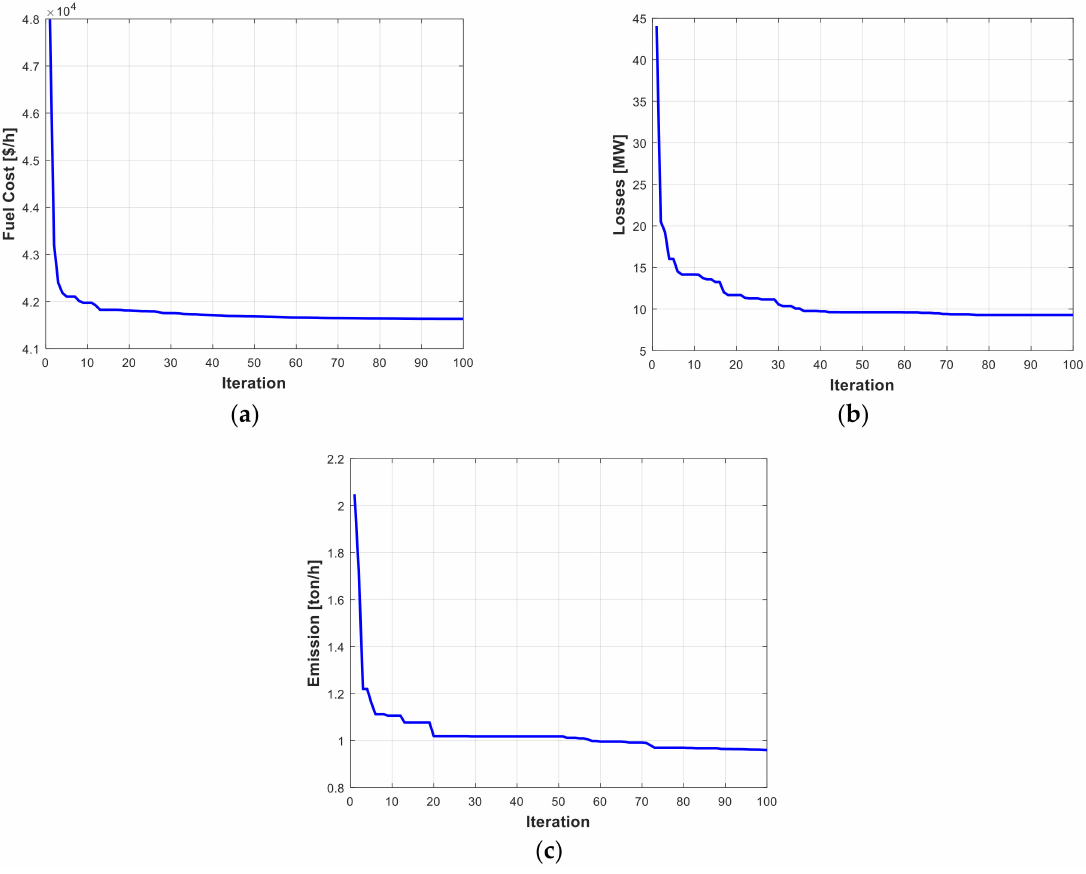
Figure 10. The convergence characteristics of the SMA for Cases 23–25. ( a ) Case 23, ( b ) Case 24, ( c ) Case